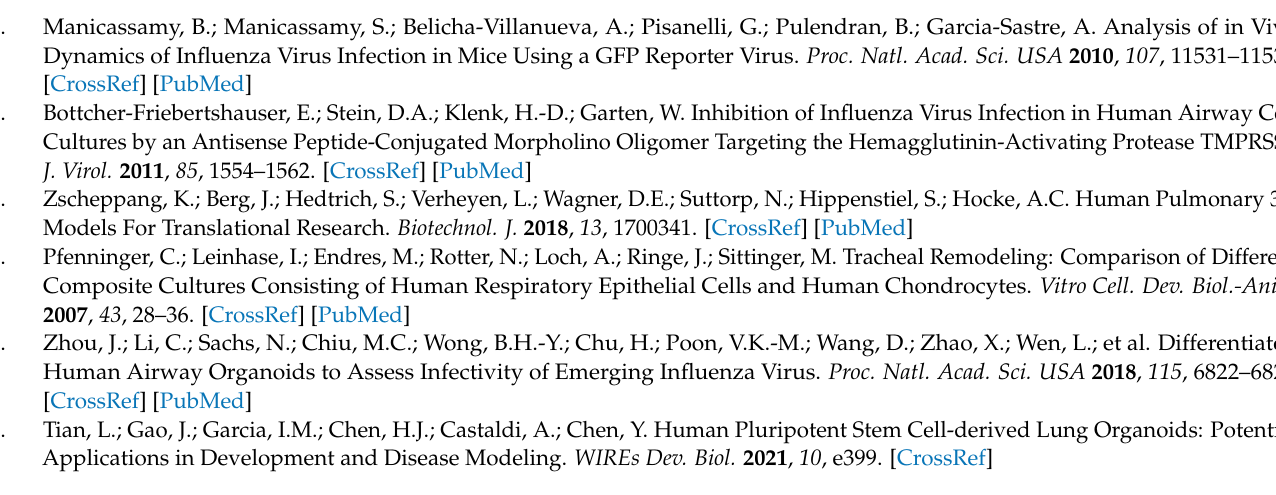
3/hpF co-culture models; Figure S3: Comparison of the concentration of total virus particles of A/PR/8/34 and NS1-RFP IAV at different MOI in 2D Calu-3 cell cultures; Figure S4: Comparison of the viral RNA concentration of A/PR/8/34 and NS1-RFP IAV at different MOIs in 2D Calu-3 cell cultures; Figure S5: Comparison of the concentration of infectious particles of A/PR/8/34 and NS1-RFP IAV at different MOIs in 2D Calu-3 cell cultures; Figure S6: Determination of the virus titer found in the supernatant of 2D Calu-3 cell infections with NS1-RFP virus over 60 hpi; Figure S7: Infection of the NS1-RFP virus in 3D submerged model (21 days of cultivation); Video S1: Time-course of NS1-RFP IAV infection between 4 h and 18 h 15 min post infection, in a 18 days old submerged 3D airway model infected with MOI 0.01; Video S2: Time-course of NS1-RFP IAV infection between 28 h and 49 h 45 min post infection, in a 18 days old submerged 3D airway model infected with MOI 0.01; Video S3: Movement of NS1-RFP starting from infected cells between 28 h and 49 h 45 min post infection, in a 18 days old submerged 3D airway model infected with MOI